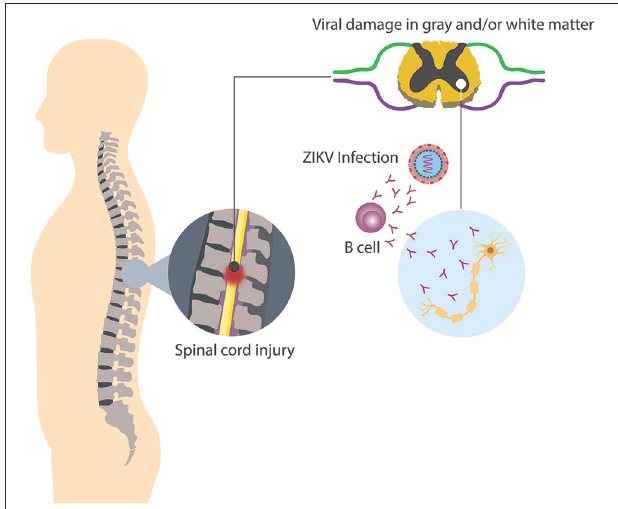
FIGURE 4 | Neurologic damage by ZIKV. Immune regulatory mechanisms fail, thus culminating in the breakdown of self-tolerance, resulting in immune-mediated attack directed against both viral and